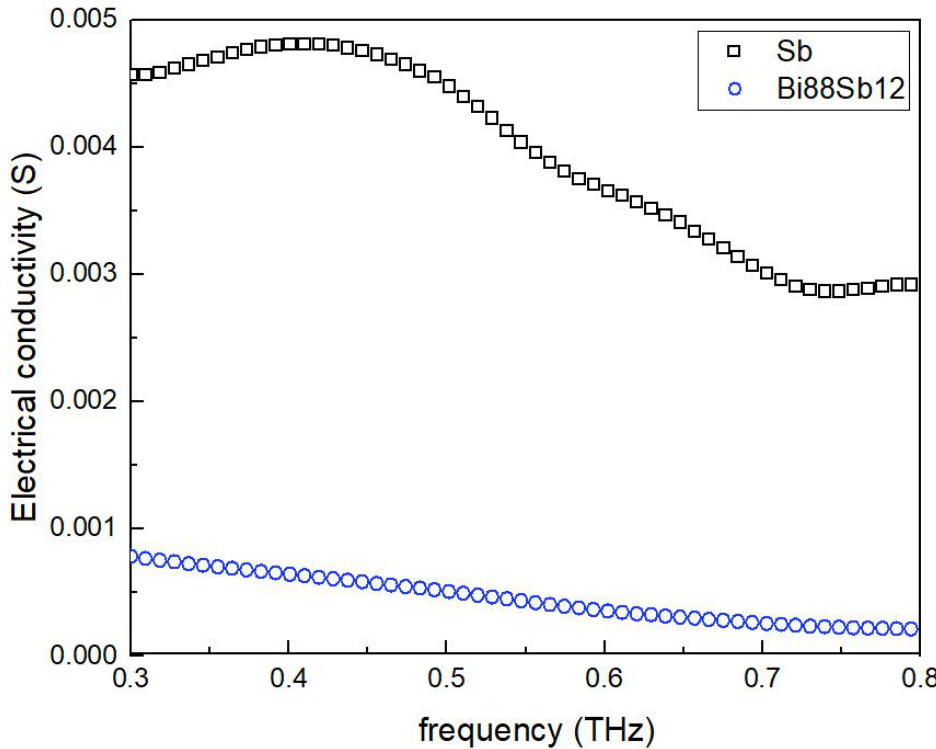
Figure 4. Electrical conductivity of antimony and bismuth antimonide 150-nm thin films on mica substrate in the frequency range of 0.3–0.8 THz.